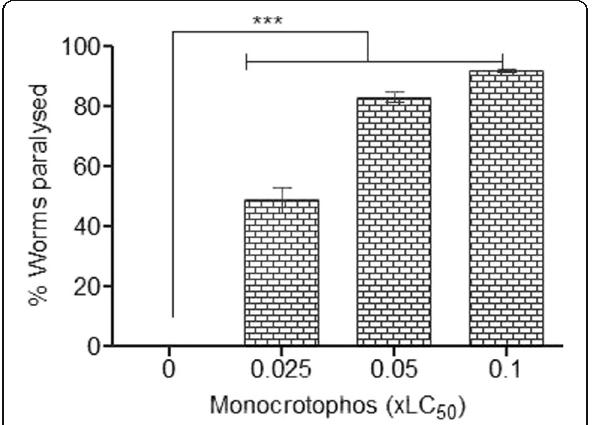
Fig. 3 Paralysis in Caenorhabditis elegans exposed to monocrotophos for 4 h. Values are mean±SE ( n =9). *** p <0.001